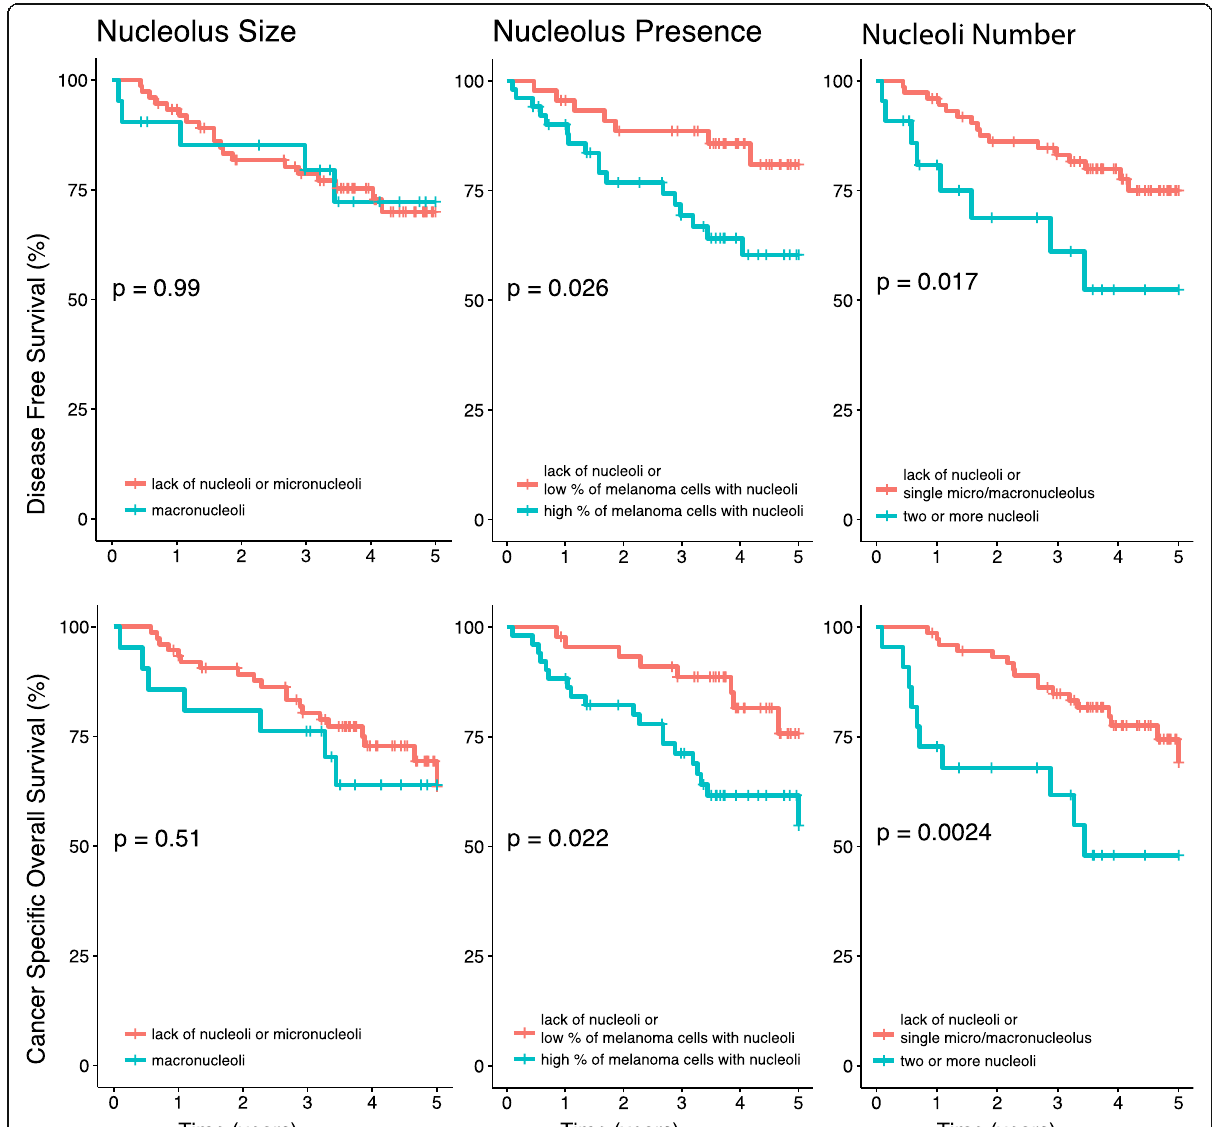
Fig. 3 Kaplan-Meier analysis of the prognostic impact of nucleoli parameters in cutaneous melanoma patients. Increased prevalence and number, but not size of nucleoli, were connected with significantly shorter disease-free and cancer-specific overall